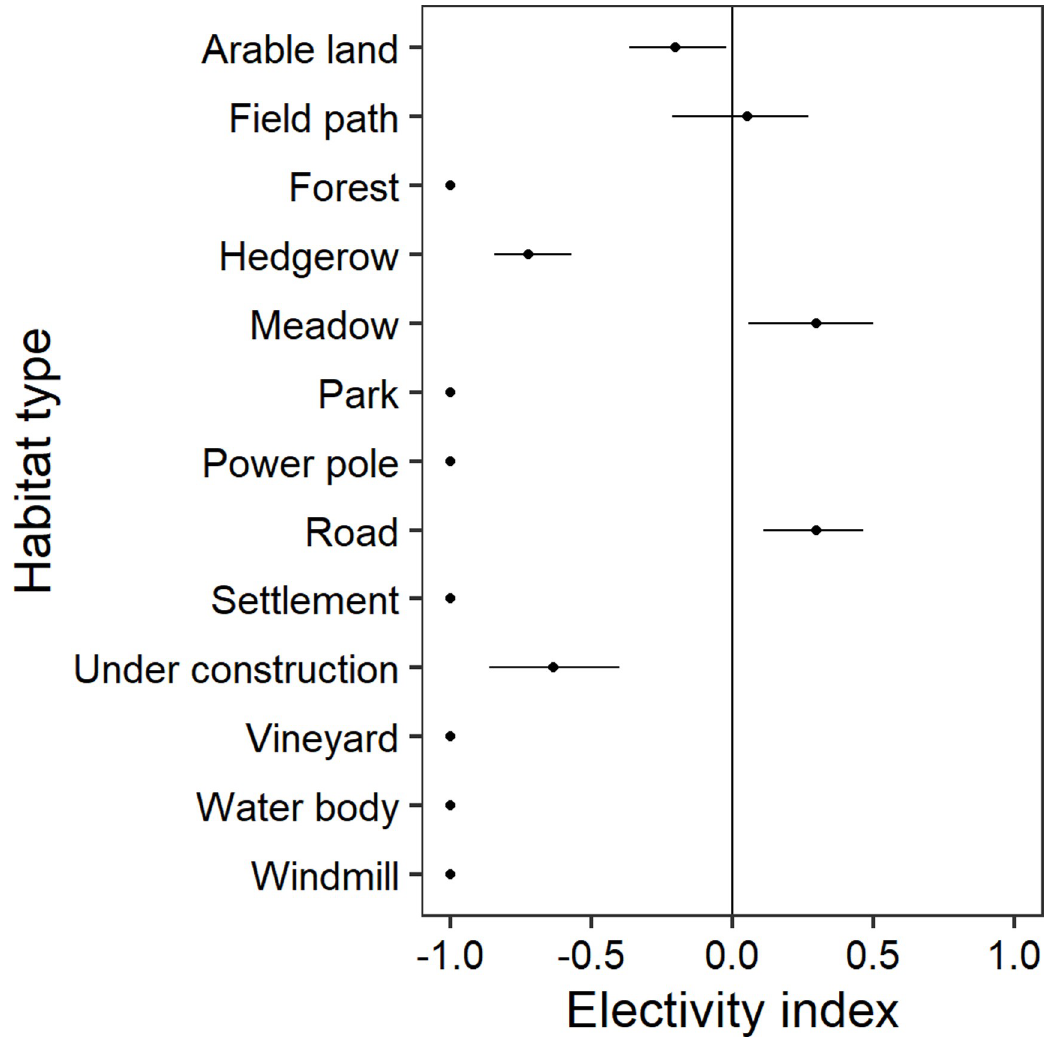
Fig 6. Chesson’s electivity indices for habitat types of the grey partridge during winter 2017. Chesson’s electivity indices and their distributions of 1500 bootstrap resamples (mean and 95% confidence interval) for habitat types of grey partridges in winter based on the annual land cover map. Grey partridge individuals (n = 43) were mapped in Vienna district, Austria, in the year 2017. Not significant results cross the vertical line at zero. See text for statistical details.